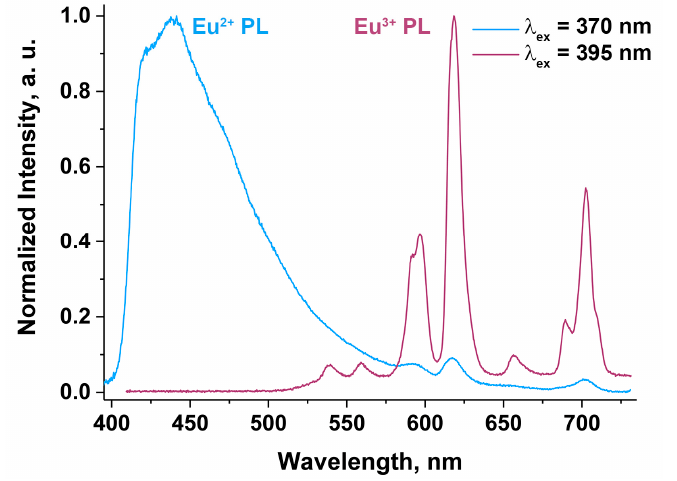
Figure 12. Normalized PL spectra of Ca 9 − x Mn x Eu(PO 4 ) 7 with x = 0.8 at λ ex = 370 nm and 395 nm. 593 nm ( 5 D 0 → 7 F 1 ), 618 nm ( 5 D 0 → 7 F 2 ) 655 nm ( 5 D 0 → 7 F 3 ) and 701 nm ( 5 D 0 → 7 F 4 ). The